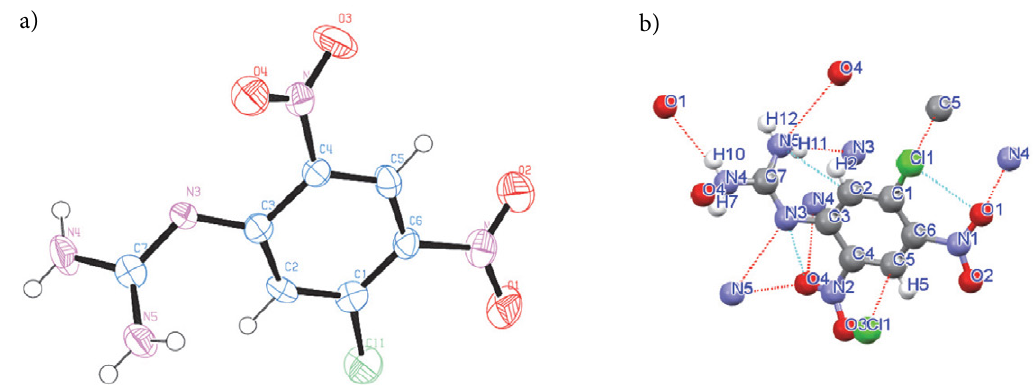
Figure 6. a. The Ortep drawing of N -(5-chloro-2,4-dinitrophenyl)guanidine ( 2 ), b. inter- and intramolecular hydrogen bonds and other interactions of N -(5-chloro-2,4-dinitrophenyl)guanidine ( 2 ), obtained using Mercury software.